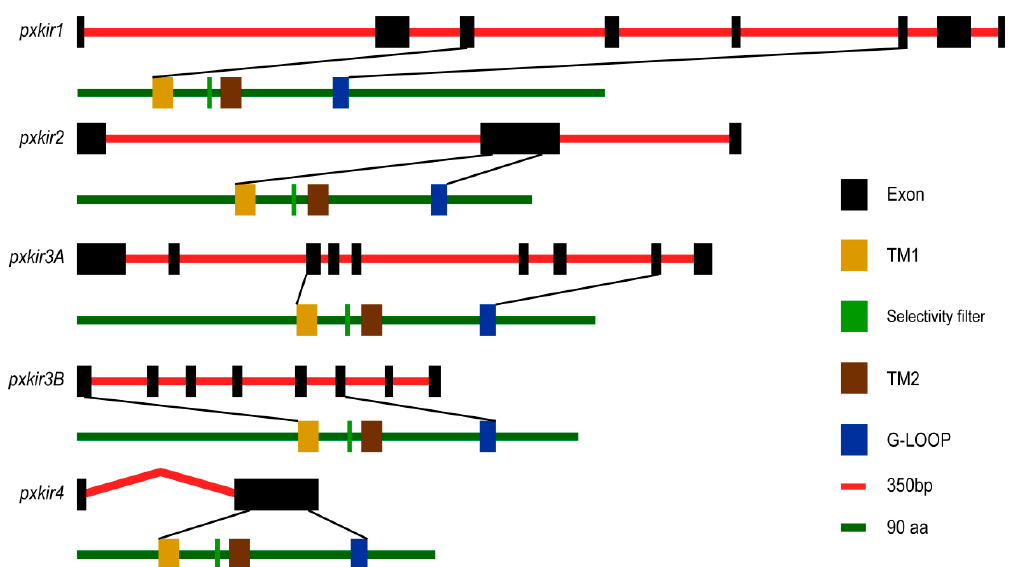
Figure 2. Genomic structures of pxkir and conservative domains of the deduced proteins. The exon–intron organization of pxkir was determined by sequence comparison between genomic sequence and cDNA sequence. The red line of every gene represents the original genomic scaffold sequences and the exons are indicated as black boxes. The green line indicates the deduced protein sequence. The locations encode the two transmembrane helices (TM1 and TM2), selectivity filters, and G-LOOP, which are marked by colored rectangles.